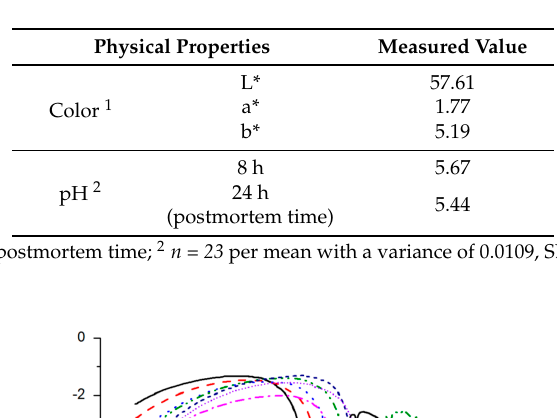
Table 2. Measured physical properties of fresh broiler meat.